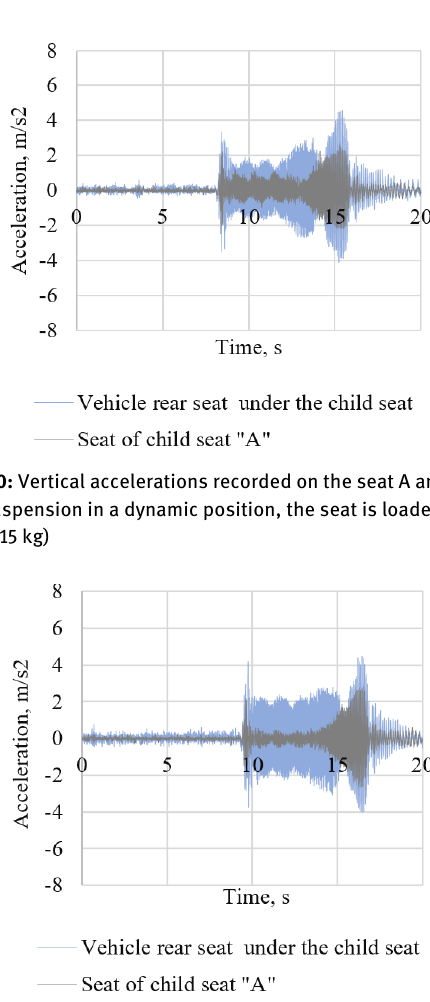
Figure 8: Vertical accelerations recorded on the seat A and ISOfix base (suspension in a dynamic position, the seat is loaded with a mass of 5 kg